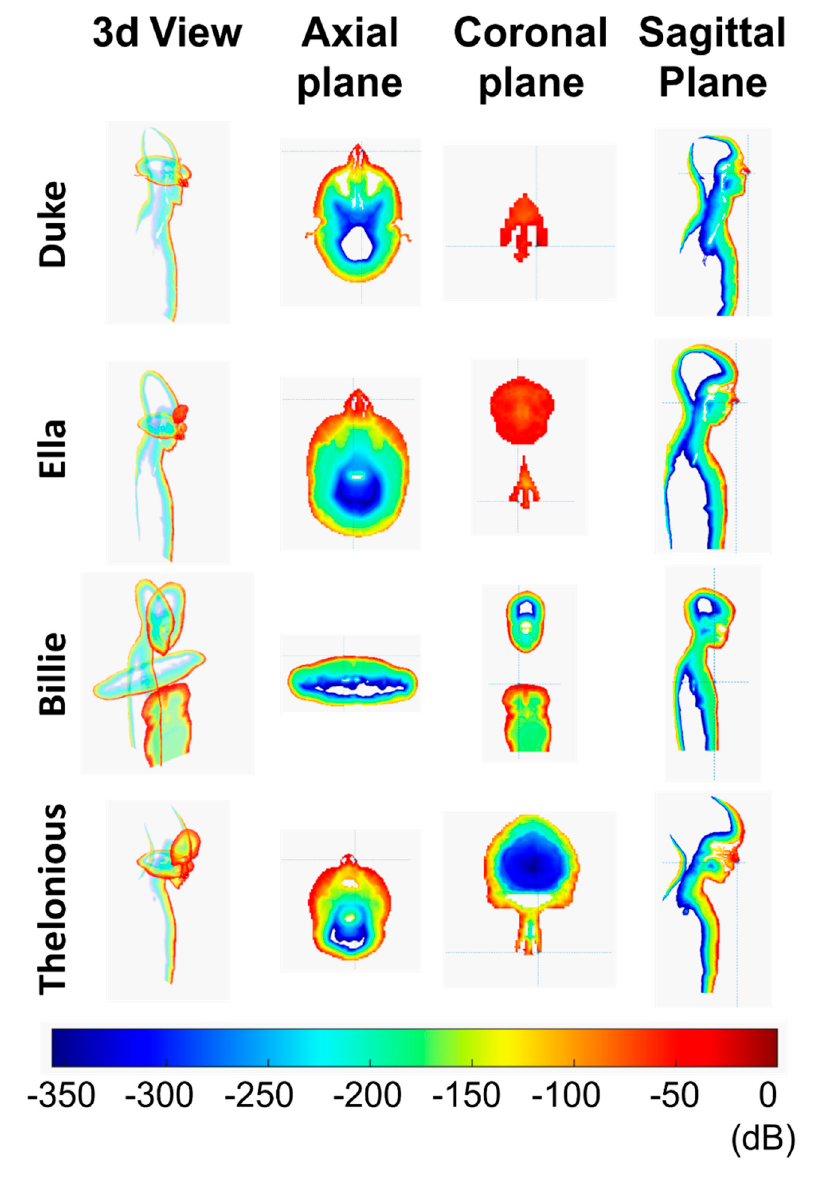
Figure 6. SAR distribution in the message writing scenario in three different planes: axial, coronal, sagittal.